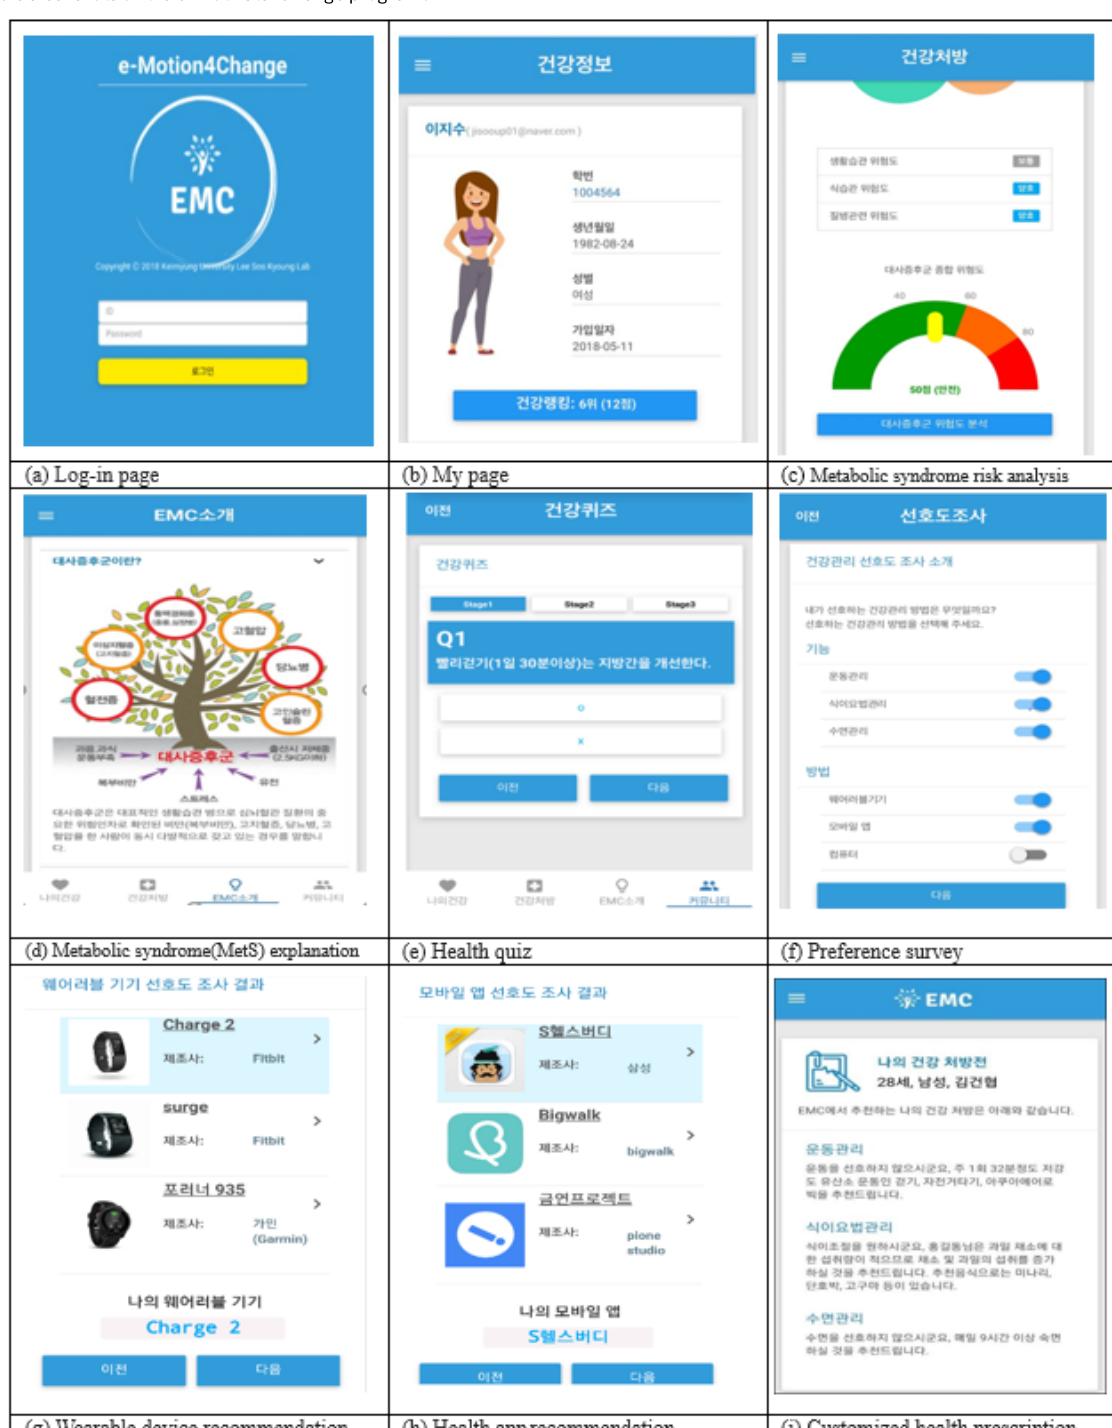
Figure 5. Screenshots of the e-Motivate4Change